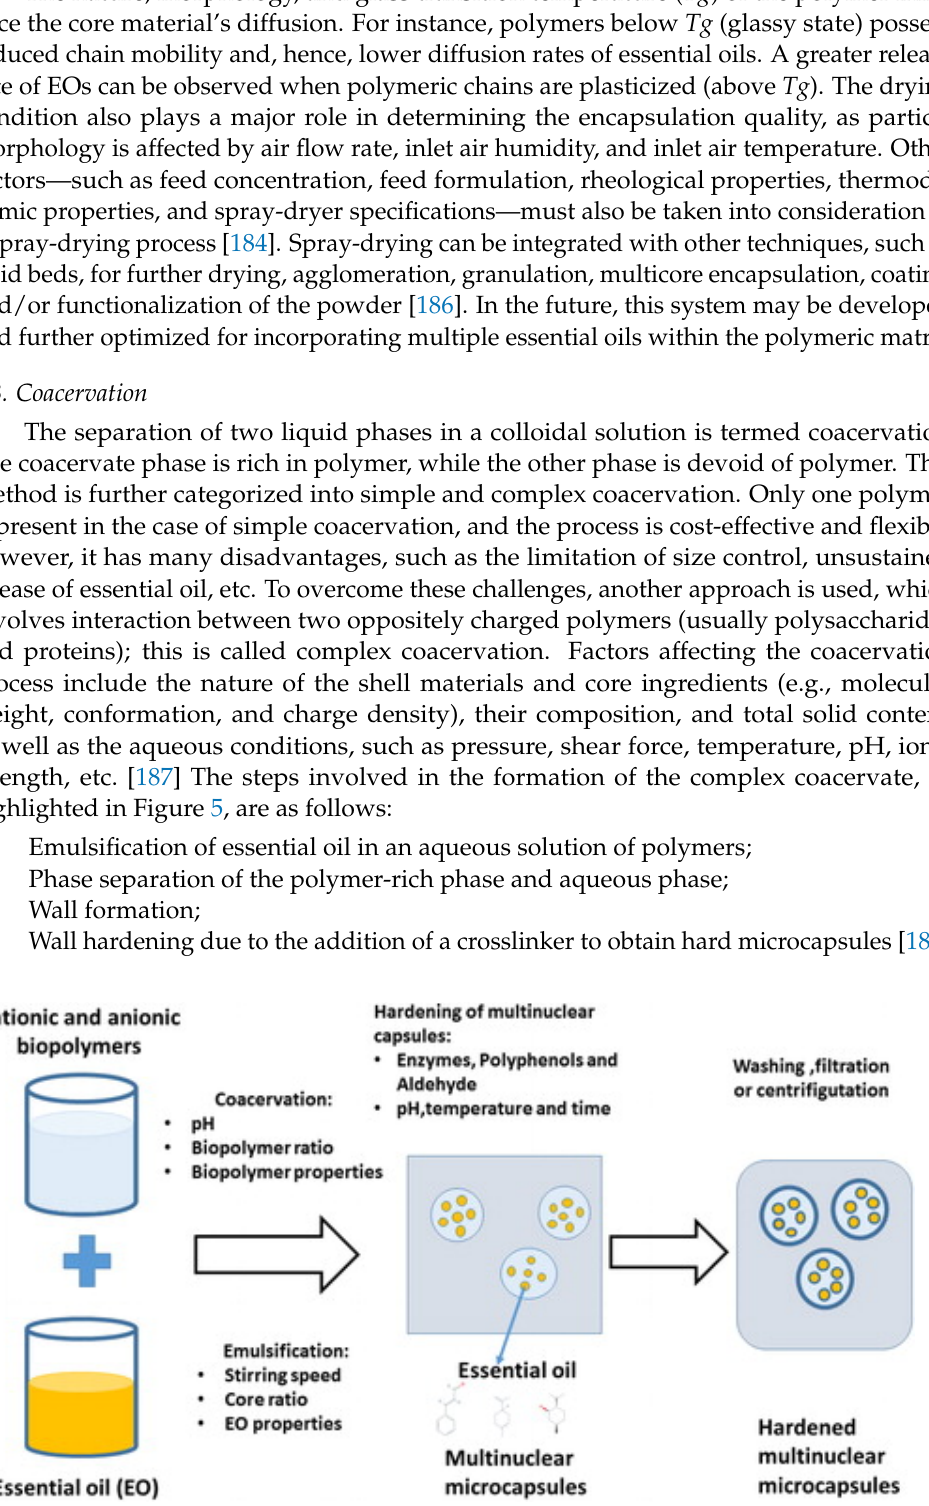
cellulose (HPMC), to form complex coacervates [189]. Polyelectrolytes